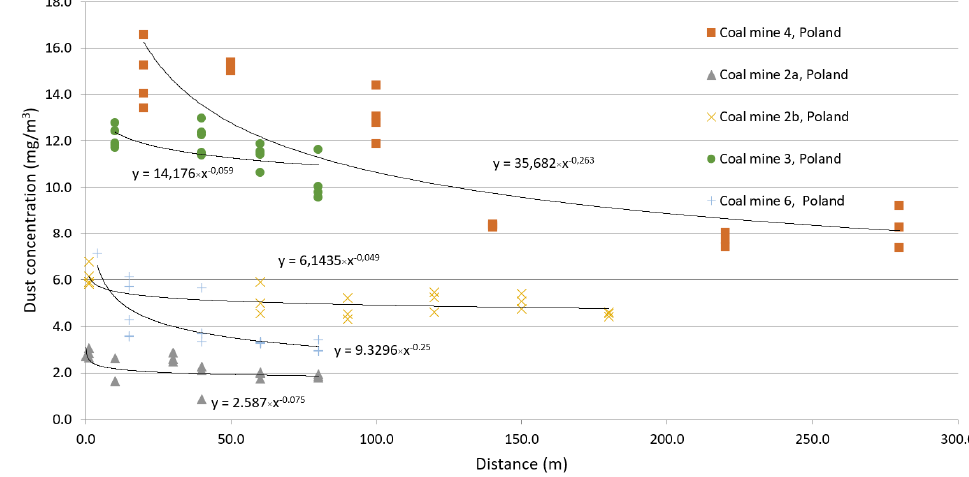
Figure 8. Characteristics of the average distribution of PM4 dust concentration in the coal face depending on the distance from a source of dust, based on dust concentration measurements with the use of CIP-10R dust meter together with the functions describing them.